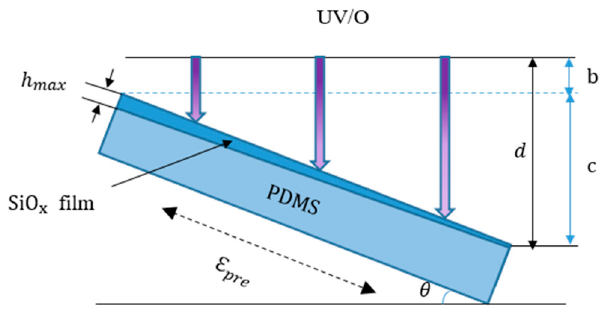
Figure 1. Schematic view of the cross section of a film with a thickness gradient prepared by inclining the PDMS substrate during exposure.